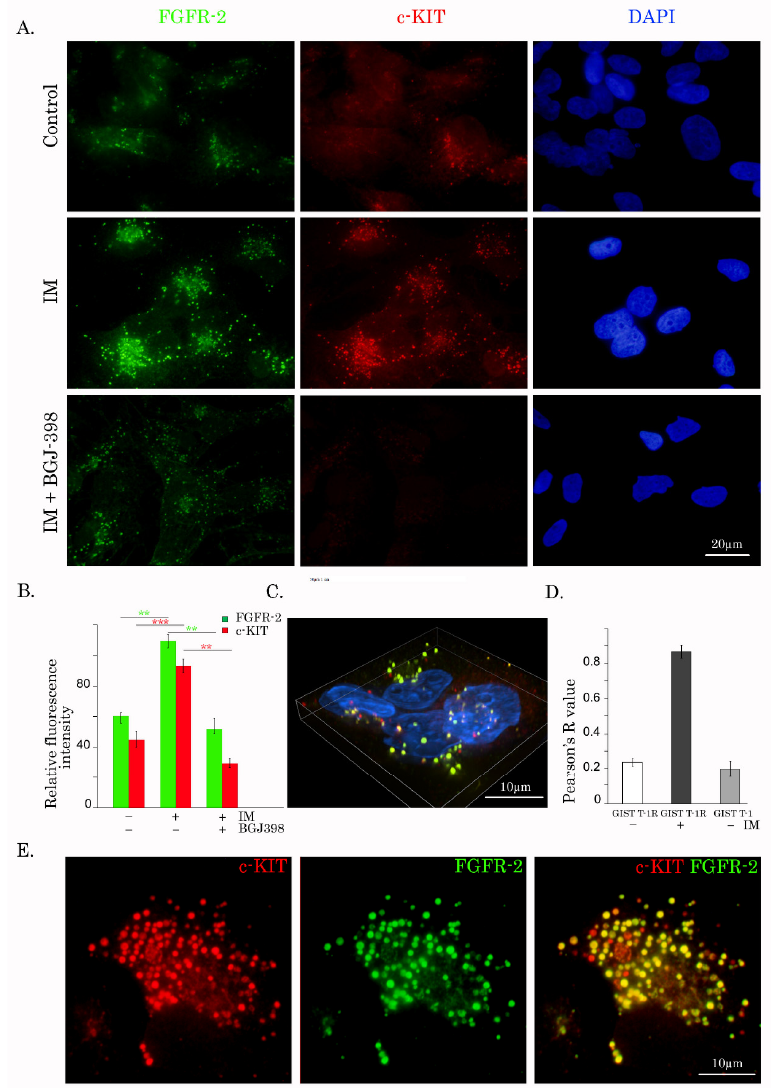
Figure 4. Crosstalk between FGFR2 and KIT in IM ‐ resistant GISTs. ( A ) IM ‐ resistant GISTs were treated with IM (1 μ mol/L) for 48 h alone (middle panel) or in the presence of BGJ398 (1 μ mol/L), a selective FGFR inhibitor (bottom panel), and subjected to the double immunofluorescence staining for FGFR2 and KIT. To outline the nucleus, the images were also merged with DAPI staining. ( B ) Quantitative analysis of relative fluorescence intensity of FGFR2 and KIT in GIST T ‐ 1R cells treated